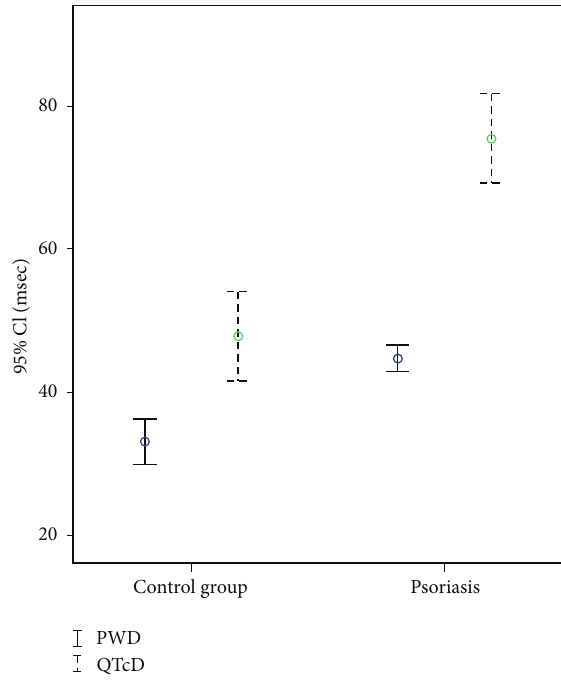
Figure 1: Error box of P wave dispersion and QTc dispersion in patients with psoriasis and control